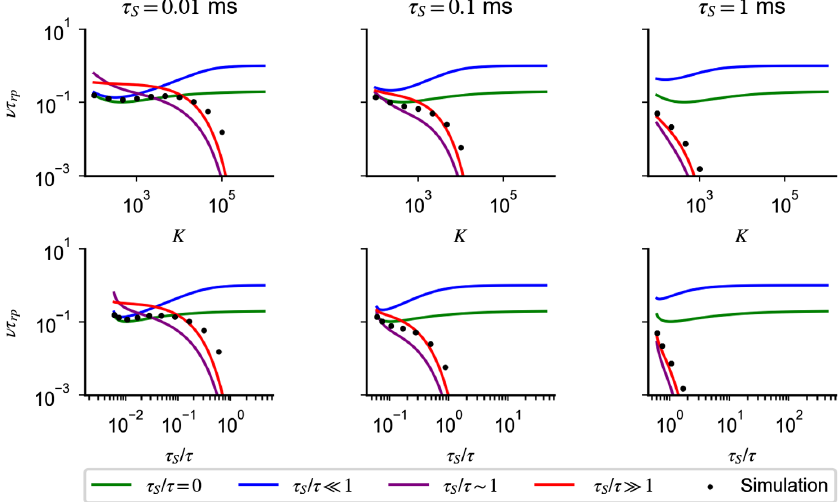
FIG. 15. Synaptic time constant suppresses single-neuron response in the strong-coupling limit. Single-neuron response for different = τ (second row); different values of K , with a rescaled according to Eq. (14). Rates are plotted as a function of K (first row) and τ S columns correspond to different synaptic time constant τ (title). As K increases, because of the synaptic time constant τ non-negligible S S compared to the membrane time constant τ , rates computed numerically from Eq. (G1) (black dots) depart from the prediction of = τ and by Eq. (G11) (red) for large Eq. (10) (green). The dependency of the rate on K is captured by Eq. (G9) (blue) for small values of τ S = τ . This decay cannot be prevented by a new scaling relation of a with K and provides an upper bound to how much coupling values of τ S can be increased while preserving response. Simulations parameter: a ¼ 0 . 006 for K ¼ 10 3 , g ¼ 12 , and η ¼ 1 . 46